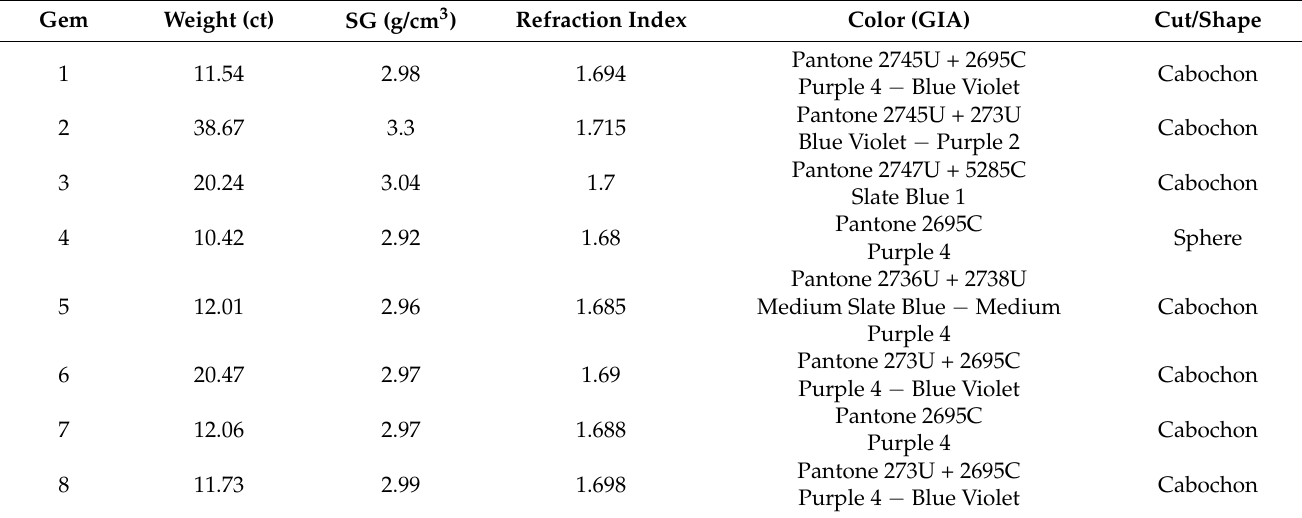
Table 1. Physical and optical